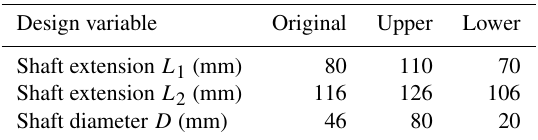
Table 4. Range of design variables.